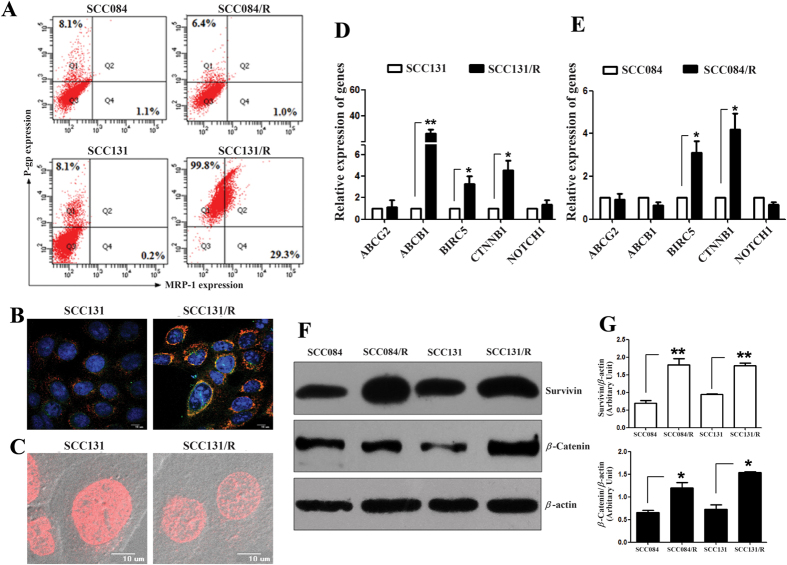
Changes in molecular properties of cisplatin-resistant cells (SCC131/R and SCC084/R) compared to their parental (SCC131 and SCC084) OSCC cells.(A) P-glycoprotein and MRP1 expression were significantly increased in SCC131/R cell line compared to the parental SCC131 cells but not in SCC084/R. Cells were stained with P-gp mouse monoclonal UIC2 followed by anti-mouse PE-conjugated secondary antibodies along with FITC-conjugated mouse monoclonal MRP-1 antibody and evaluated using FACS. (B) Representative image of confocal microscopy for P-gp and MRP expression in SCC131 and SCC131/R cells. Cells were stained same as FACS –staining except P-gp mouse monoclonal antibody C219 for Confocal microscopic analysis. (C) Confocal microscopic images showing the doxorubicin accumulation was significantly reduced in SCC131/R cells compared to SCC131 cells. After seeding a day before cells were incubated with doxorubicin (10 μM) for 1 h at 37 °C then washed with PBS before glycerol mounting and analysed immediately for intracellular accumulation of doxorubicin using confocal microscope. (D,E) mRNA expression level of ABCG2, ABCB1 (P-gp), BIRC5 (survivin), CTNNB1 (β-catenin) and NOTCH1 in both the resistant (SCC131/R: D and SCC084/R: E) cells compared to their parental (SCC131: D and SCC084: E) cells. Total RNA isolated was reverse transcribed and the cDNA subjected to qRT-PCR using gene specific forward and reverse primers. Relative expression values were normalized to those of 18 s rRNA. (F) Western blot images showing the survivin and β-catenin protein expression were significantly increased in both resistant (SCC131/R and SCC084/R) cells compared to their parental cells (SCC131 and SCC084). Whole cell-lysates from different cell lines were subjected to western blot using specific antibodies. Relative expression values were normalized to those of β-actin. (G) Densitometric quantification of survivin and β-catenin protein band in resistant and parental cells. Immunoractive bands were quantified and expressed as the ratio of each band density to after normalization to loading control (β-actin) band density. For (D,E,G), data represent three independent experiments and expressed as mean ± SE. For (A–C,F), images are representative of three independent experiments. *p < 0.05, **p < 0.01, ***p < 0.001.